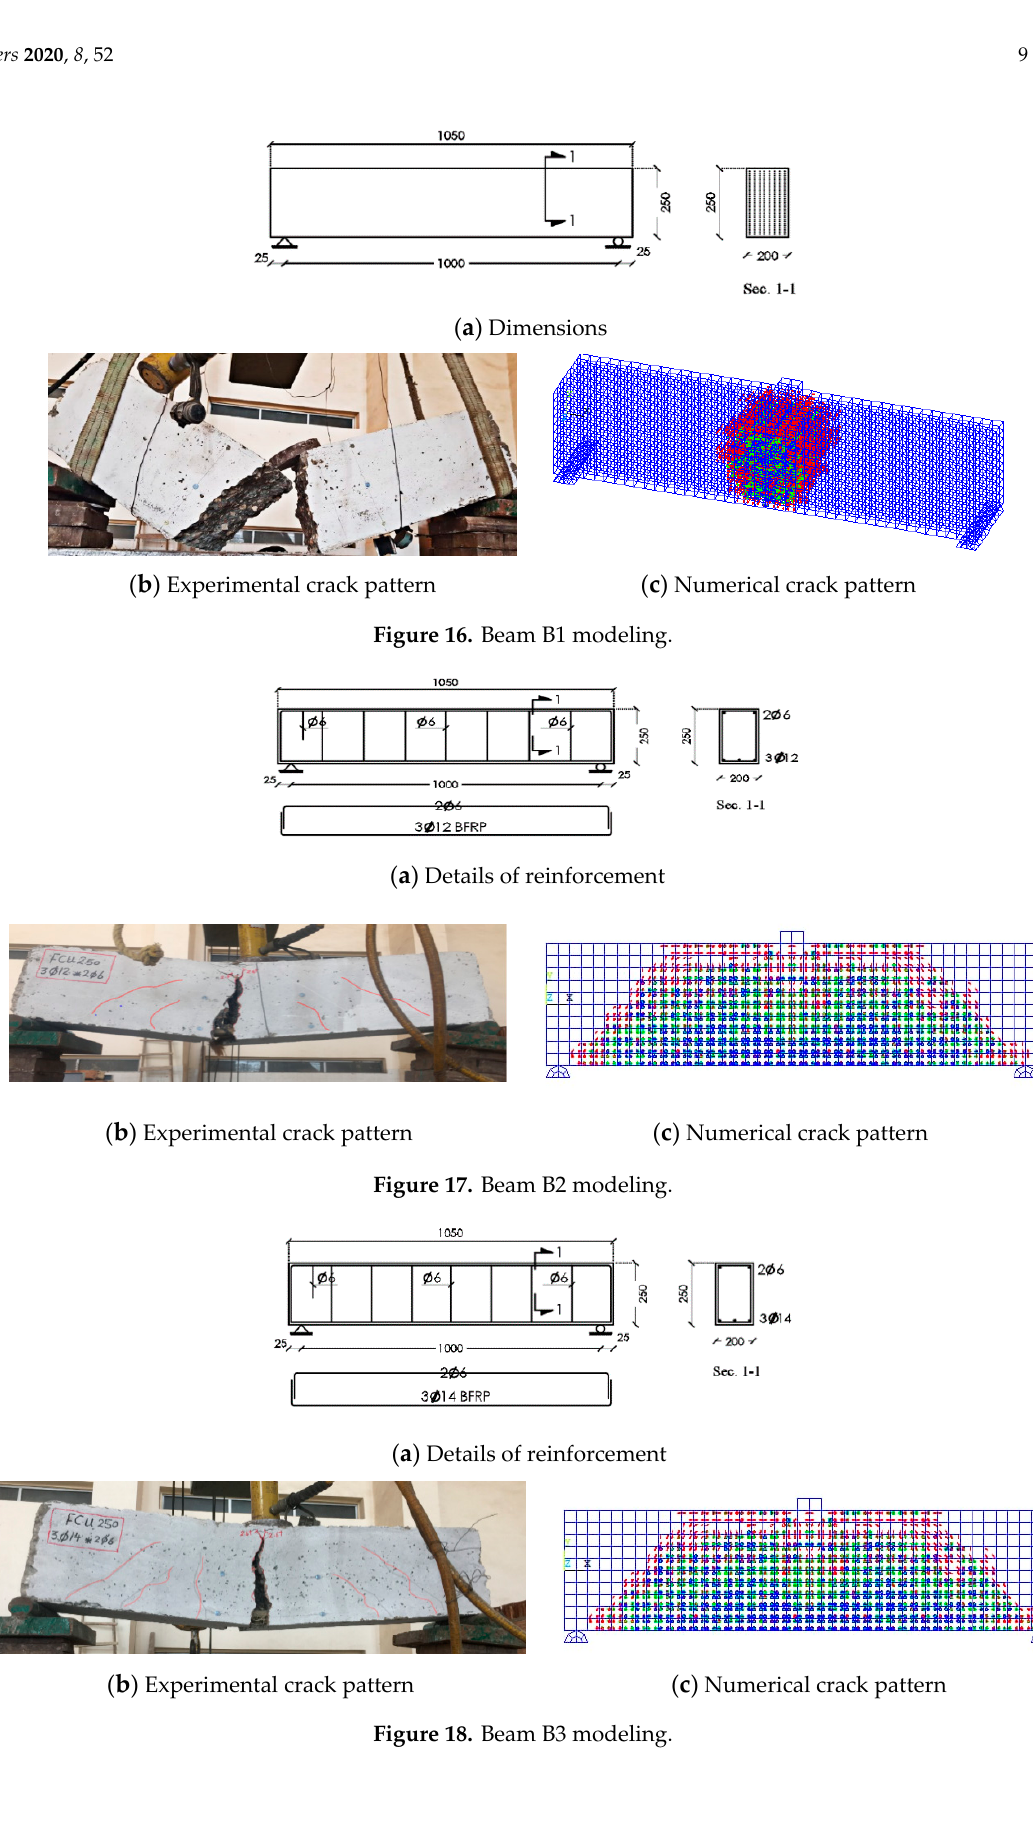
( c ) Numerical crack pattern Figure 20. Beam B5 modeling.